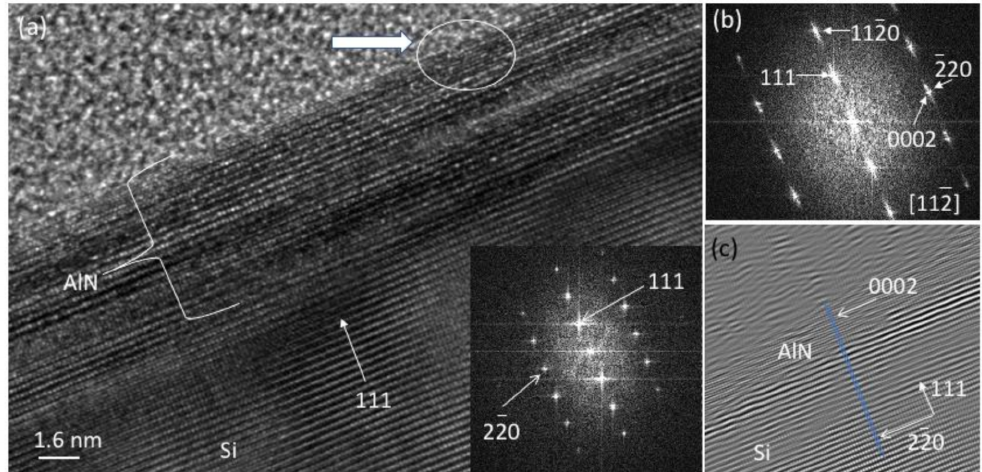
Figure 2. ( a ) High-resolution transmission electron microscopic (HRTEM) image near the [11-2] zone of Si showing the AlN layer and relative sharper Si/AlN interface. The Fast Fourier transforms (FFT) from the substrate only has been shown as an inset. ( b ) FFT obtained from the portion of film and the substrate. The spots have been indexed. ( c ) IFFT image of the AlN film and the substrate. The HRTEM image near the [112] zone (see Figure 3) of Si from another portion of the film at a higher magnification shows a rather sharp interface with a dot-dashed line. The crystallographic a-direction <11-20> is indicated in the image. In the observed orientation relationship, the estimated strain, (d 2-20 Si -d 0002AlN )/d 2-20Si , perpendicular to the growth direction is 0.8%, using d 2-20Si = 0.191 nm and d 0002AlN = 0.1895 nm. The strain type in this case would be tensile. However, for cubic AlN on Si (111), the strain would be more than 10% as d 200 AlN = 0.218 nm, suggesting that the hexagonal AlN would be favored on Si (111) as compared to the cubic AlN on Si (111).